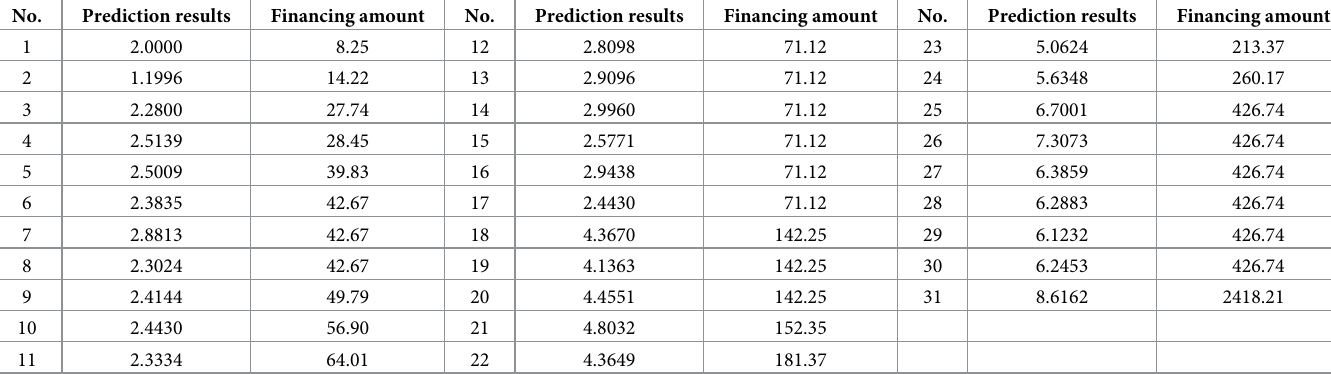
Table 5. Correspondence table between the prediction results and the financing amount.